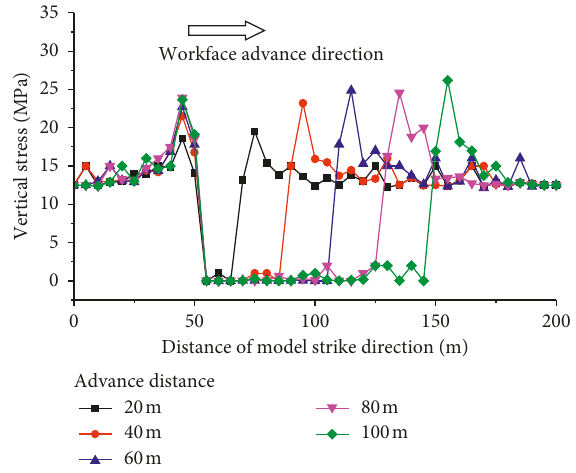
Figure 16: The stress distribution of coal seam.